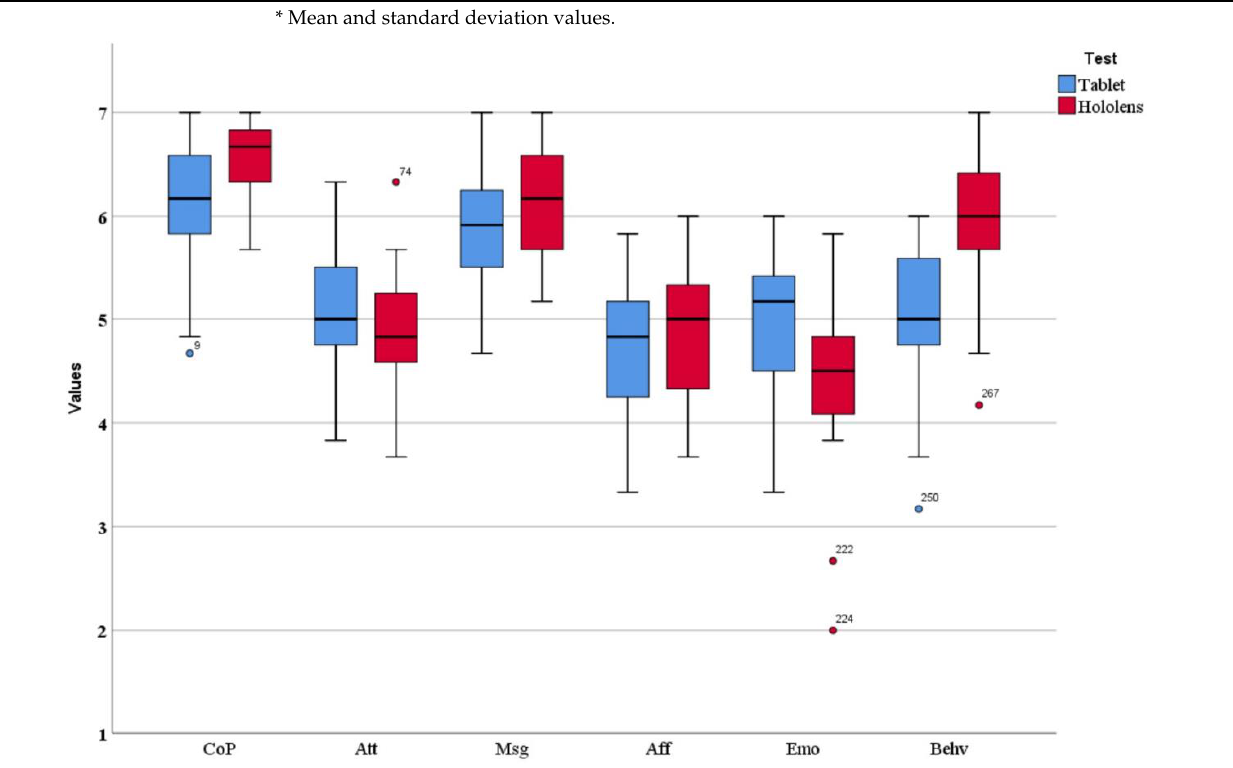
Figure 4. Box plots with the results for the Likert scale rating: Co-presence (CoP), Attentional Allocation (Att), Perceived Message Understanding (Msg), Perceived Affective Understanding (Aff), Perceived Emotional Interdependence (Emo), and Perceived Behavioral Interdependence (Behv).